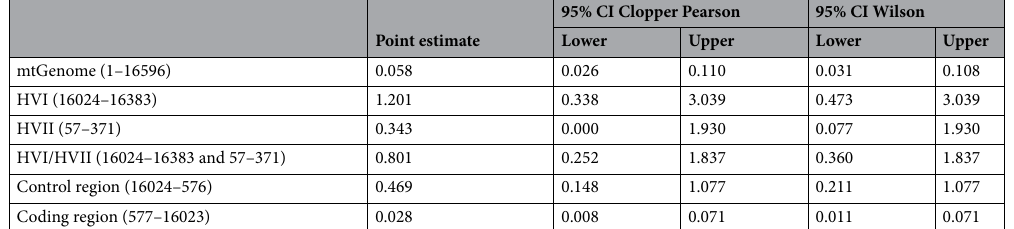
Table 2. Mutation rates for the NI extended pedigree. Pedigree derived mutation rate calculated for various regions of the mtGenome. Rates are expressed in mutations per site per million years (26.9 year generation time). mtGenome, mitochondrial genome; HVI, hypervariable region 1; HVII, hypervariable region II. All the mutations (including heteroplasmy) that were detected were